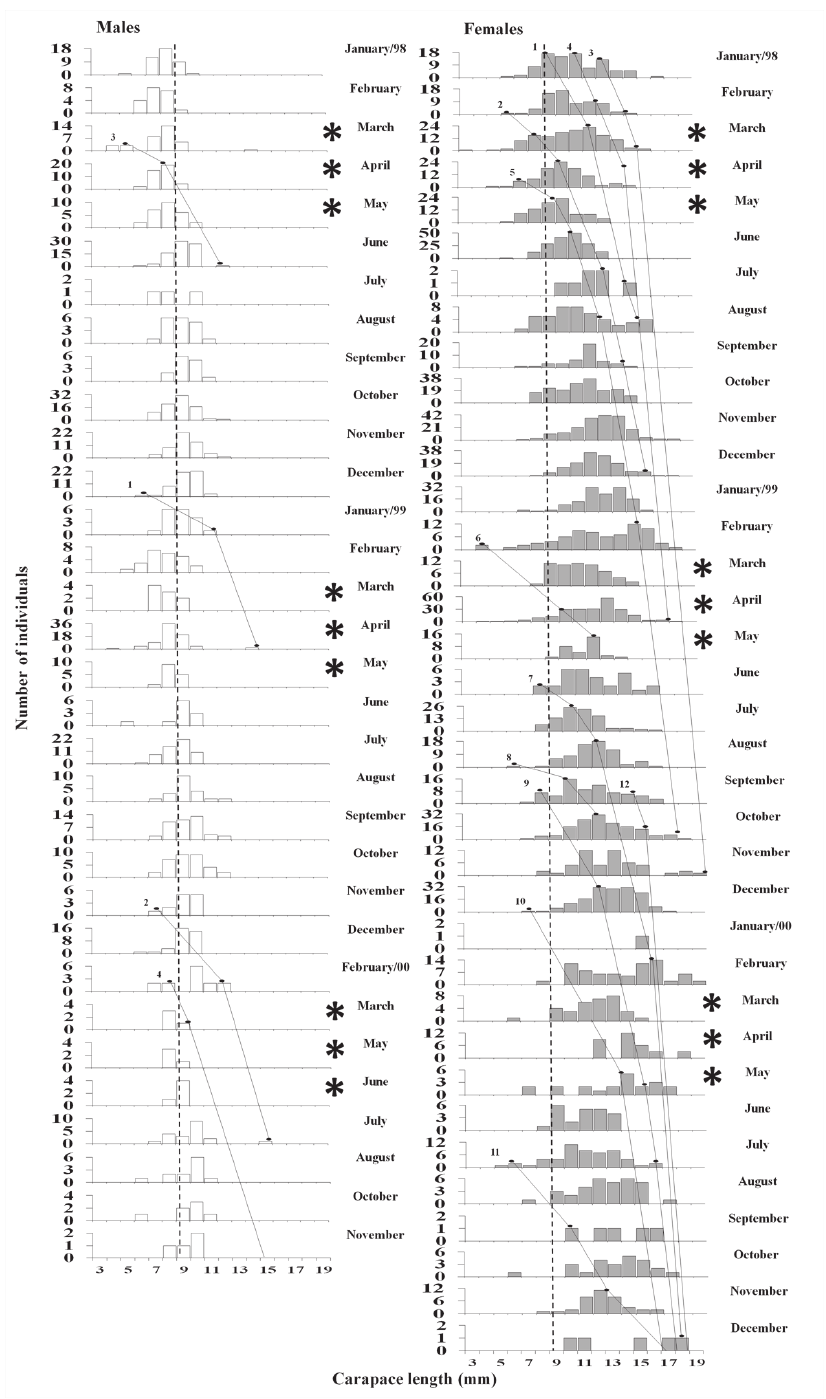
Figure 4 - Rimapenaeus constrictus . Selected cohorts (lines) for growth analyses performed on data sampled from January 1998 to December 2000 at the Northern littoral of São Paulo state. Dotted lines: recruitment size (9.4 mm CL); *: periods in which shrimp- fishing activities are prohibited by the responsible federal environmental